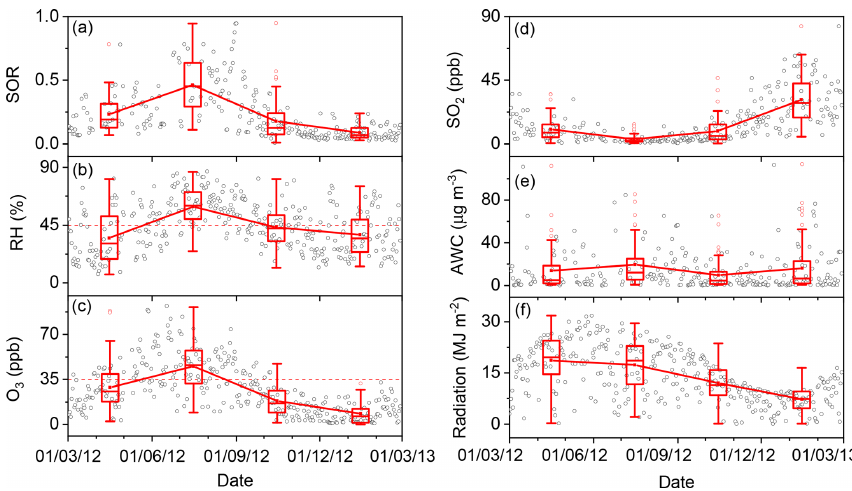
Figure 9. Time series of (a) SORs, (b) RH, (c) O 3 , (d) SO 2 , (e) aerosol water content (AWC), and (f) solar radiation from 1 March 2012 to 28 February 2013 (open black circles). The boxes represent, from top to bottom, the 75th, 50th, and 25th percentiles for each season. The whiskers, solid red squares, and open red circles represent 1.5 times the IQR, seasonal mean values, and outlier data points, respectively. The horizontal dashed lines in panels (b) and (c) represent thresholds of RH = 45% and O 3 = 35ppb, respectively.